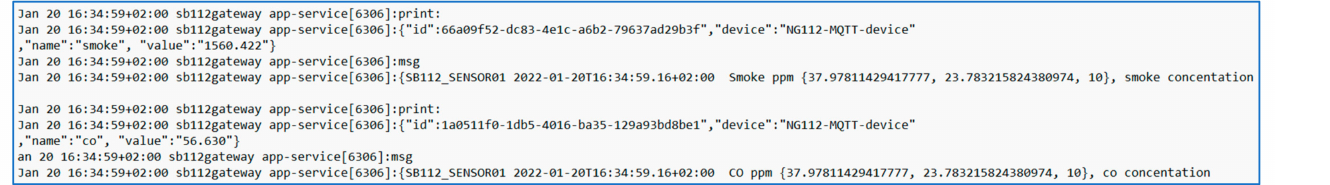
Figure 11. The Middleware Application Service prints concentration values from the smoke and CO sensors that exceed the